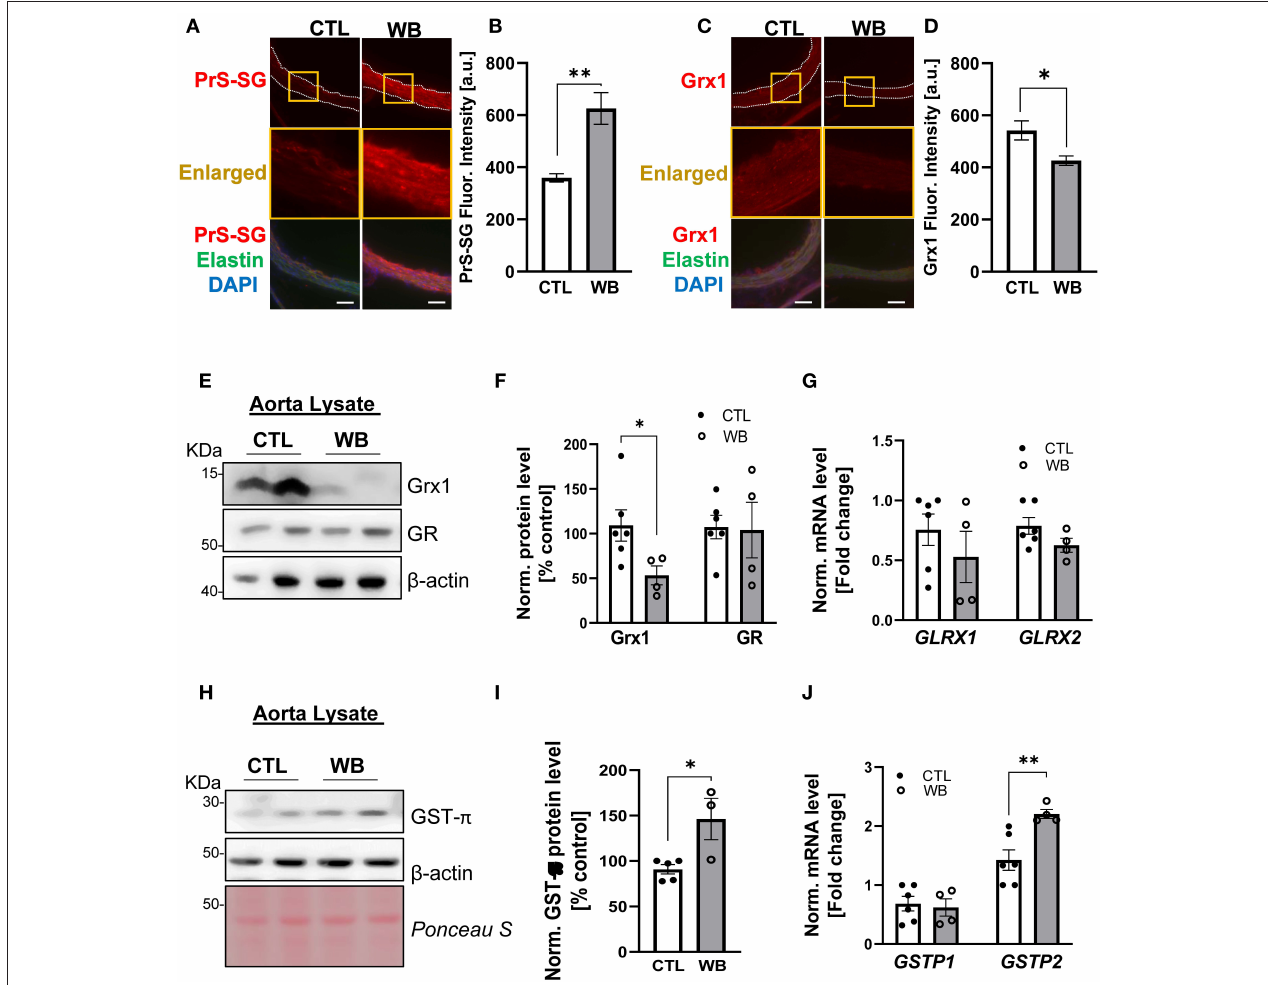
FIGURE 3 | Weekend-binge drinking leads to decreased Grx1 and increased GST- π expression in aortic tissue in ApoE − / − mice. (A–D) Immunofluorescence analysis of (A,B) PrS-SG and (C,D) Grx1 expression in the aorta of pair-fed control (CTL) or Weekend-binge ethanol-fed (WB) ApoE − / − mice. Fresh and frozen cross-sections of aorta without evident lesions were immunostained for (A) PrS-SG and (C) Grx1 and fluorescence (red) was then (B,D) quantified using Icy ImageJ software. Nuclei were counterstained with DAPI (blue), and elastin was visualized via its autofluorescence (green). The vessels are outlined in white dashed lines, yellow boxes indicate the area shown in higher magnification below the corresponding images. For each aortic cross-section the red fluorescence intensity was measured in three randomly selected image fields, average, and expressed as arbitrary units (A.U.). (E–J) Descending aorta from ApoE − / − mice from control (CTL) and Weekend-binge (WB) ethanol-fed mice were analyzed for (E–G) Grx1, GR, and (H–J) GST- π using immunoblotting and qPCR. Weekend-binge ethanol feeding reduces the expression of (E,F) Grx1 on protein but not (G) mRNA level in ApoE − / − mice compared to control group and has no effect (E–G) on the expression of GR. (H–J) In the weekend-binge group the level of GST- π (H,I) protein and (J) mRNA is higher than those in the controls. (E,H) Representative immunoblot results and (F,I) densitometric analysis of Grx1, GR, and GST- π in the tissue lysate. (G,J) mRNA results of GLRX1, GLRX2, GSTP1 , and GSTP2 in the tissue lysate. Bars